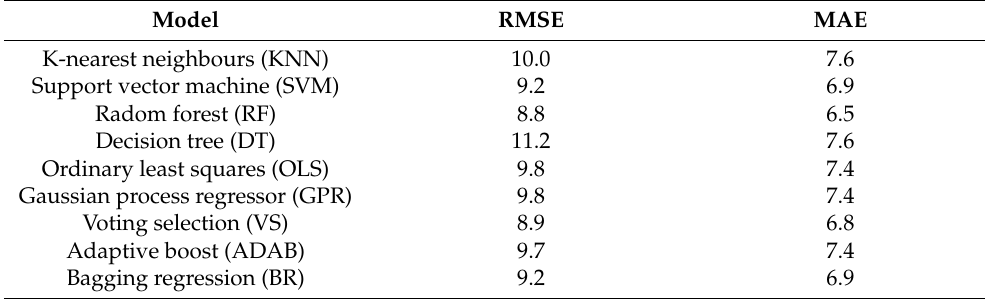
Table 2. Performance of machine learning